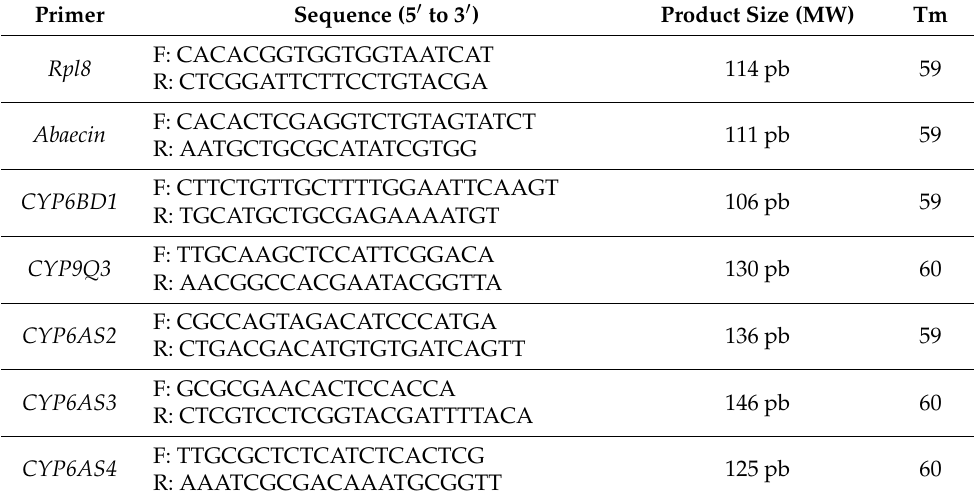
Table 1. Primer models. Sequence, amplified size product and melting temperature for the constitu- tive gene ( Rpl8 ) and target genes Abaecin , CYP6BD1 , CYP9Q3 , CYP6AS2 , CYP6AS3 ,